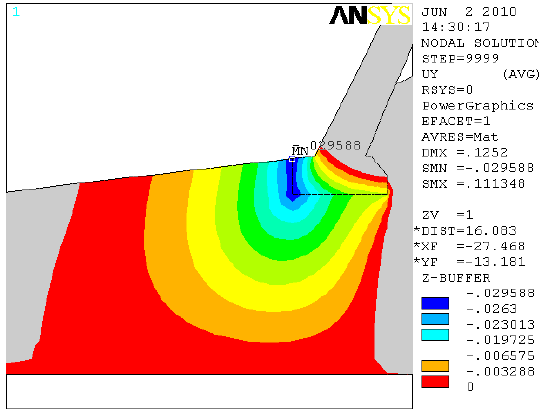
Fig. 8 Retaining wall foundation settlement diagram.